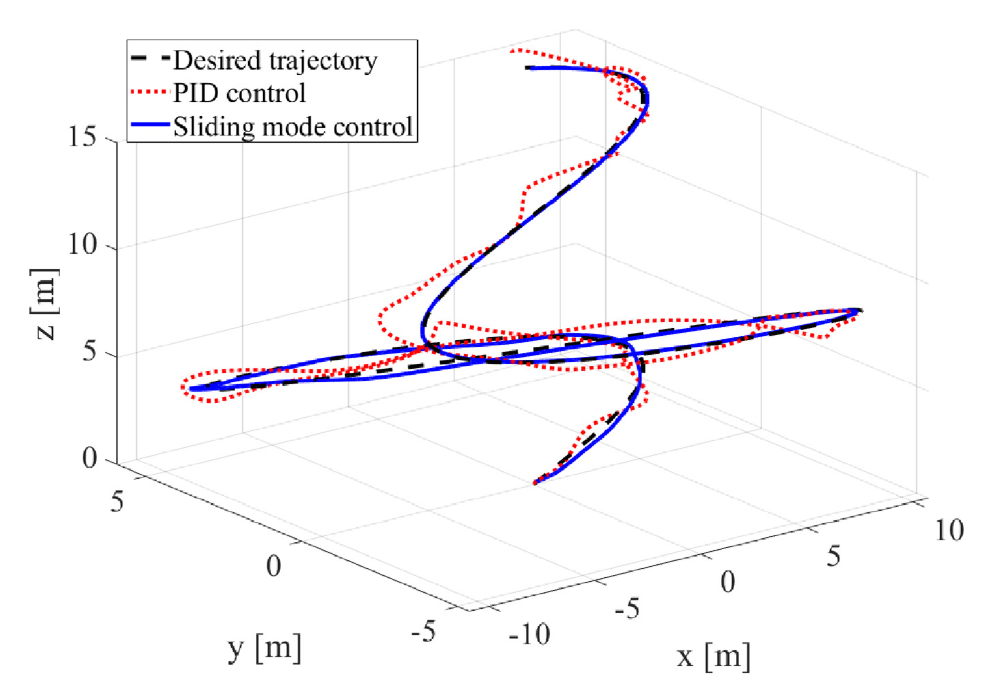
Figure 9. Trajectory tracking performance of the flying type firefighting system with disturbances in three-dimensional view.